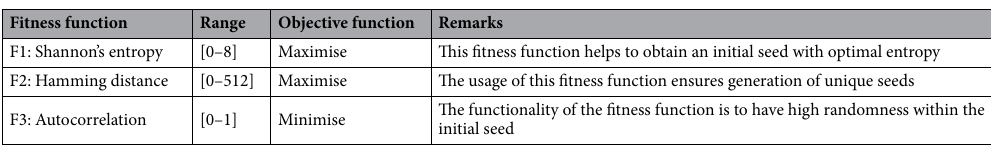
Table 4. The different fitness functions along with their range of values used for the design of